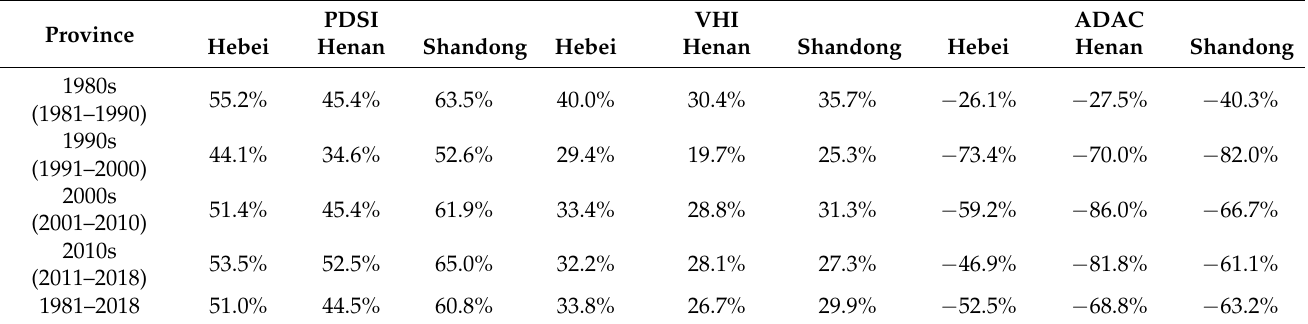
Table 1. Decade drought area percentages from PDSI and VHI, and agricultural drought-affected area changes (ADAC) during 1981–2018 for Hebei, Henan and Shandong